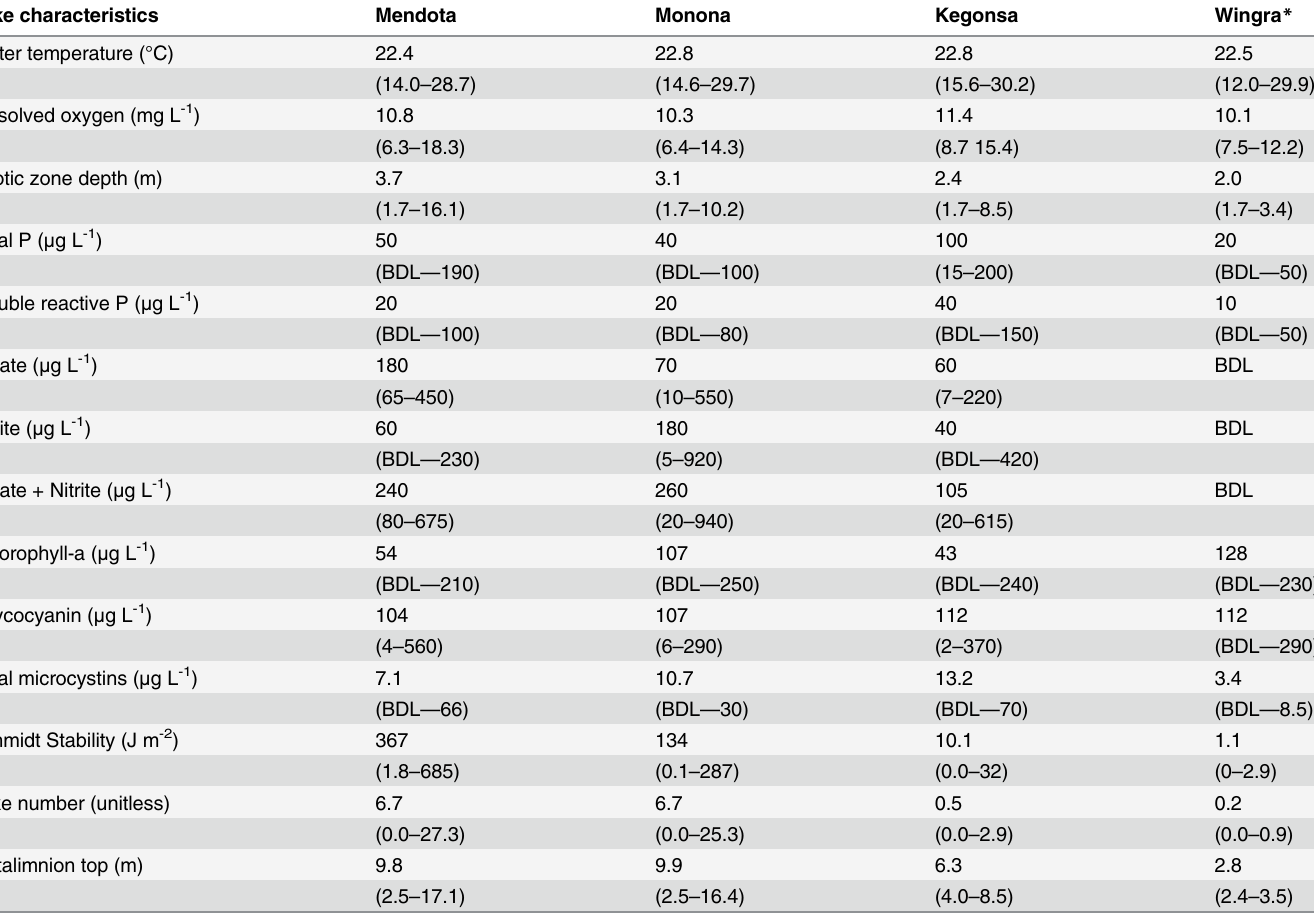
Table 2. Average (range) environmental characteristics of the 4 eutrophic lakes sampled in this study from May-October. BDL = below detection limit.